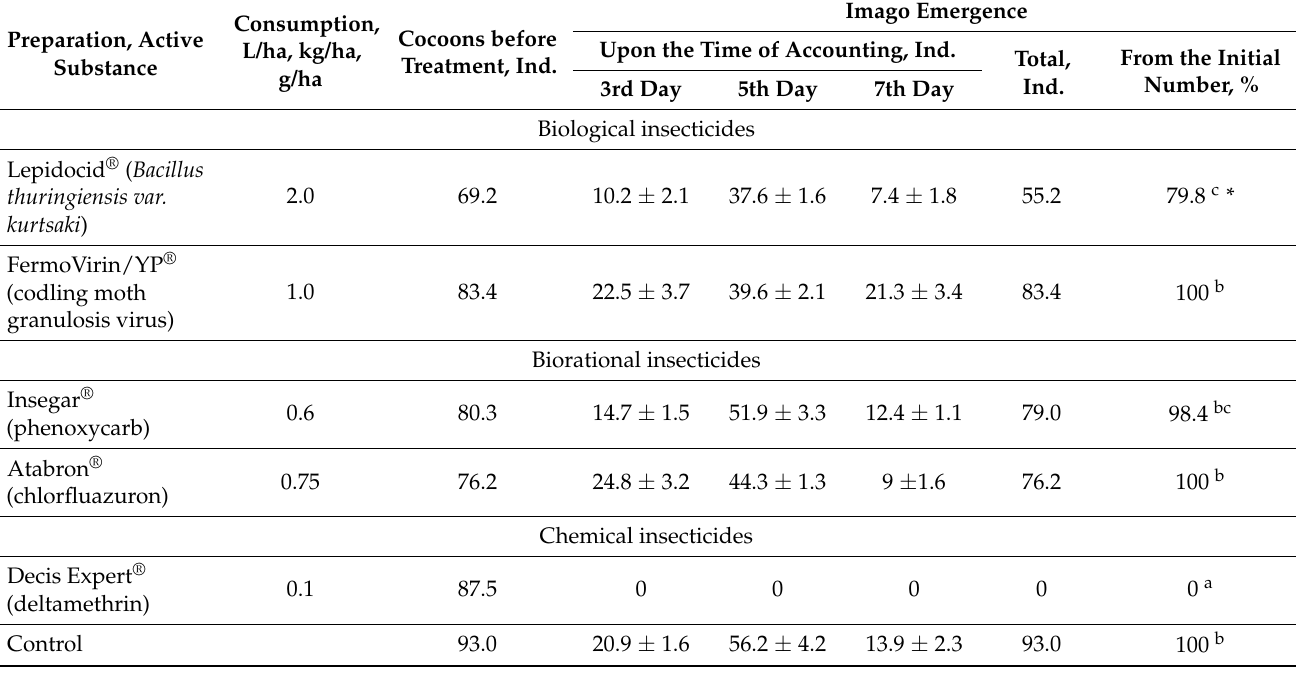
Table 5. Susceptibility of H. hebetor to biological and chemical insecticides in a laboratory test, (M ±